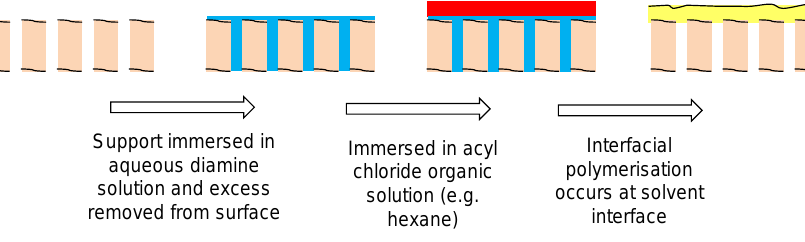
Figure 20. Schematic of interfacial polymerization.